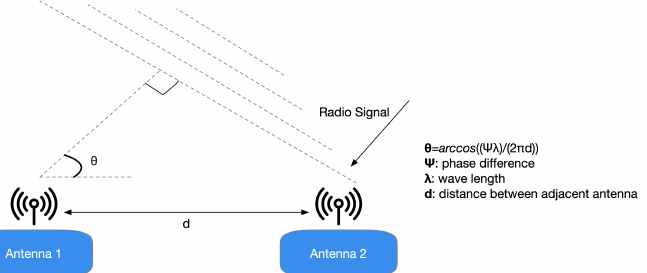
Figure 2. It is conceivable to estimate a radio signal’s arrival angle knowing specific information between neighboring antennas, such as each antenna’s distance, the wavelength, and the signal phase.